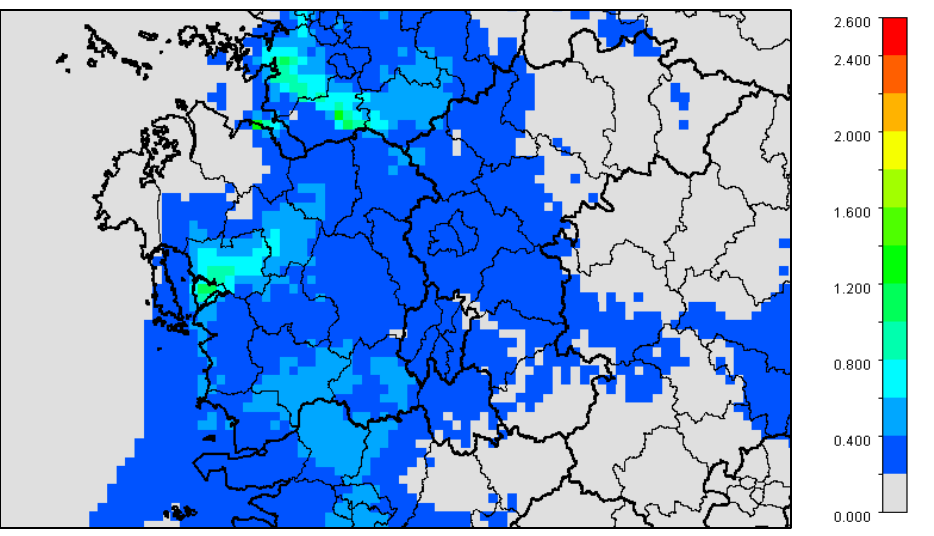
Figure 14. Monthly mean improvement of PM 2.5 concentration under S2 . Table 11. Predicted average change of PM 2.5 concentration under S2 relative to the Base case in Chungcheong in March 2017 .